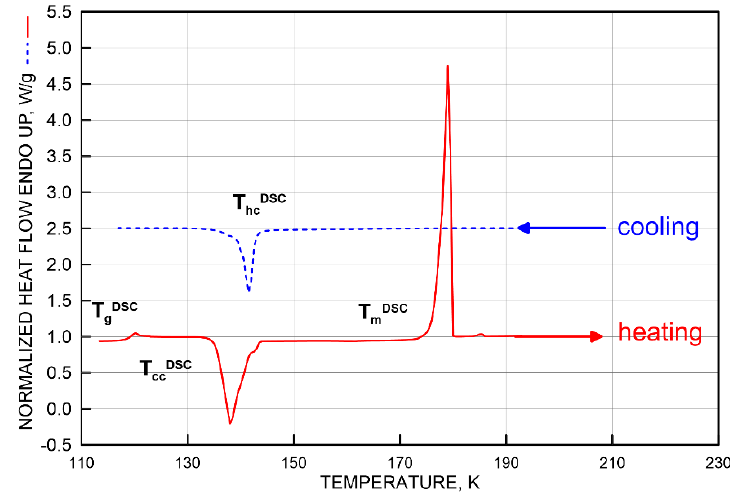
Figure 1. Basic DSC thermogram of TOL consisting of cooling scan followed by heating one with cooling/heating rates of − 5/+10 K/min. All the exothermic effects from hot and cold crystallizations and the endothermic effects from devitrification and melting are marked by the following four onset characteristic DSC temperatures T hc,onDSC = 143 K, T g,onDSC = 117.5 K, T cc,onDSC = 135 K and T m,onDSC = 178 K as described in the text.